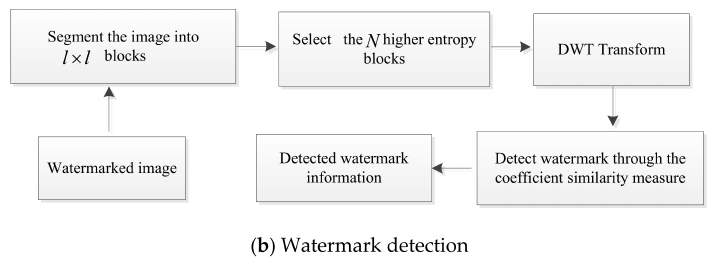
Figure 2. Flow chart of the proposed watermarking method. ( a ) Embedding; ( b )